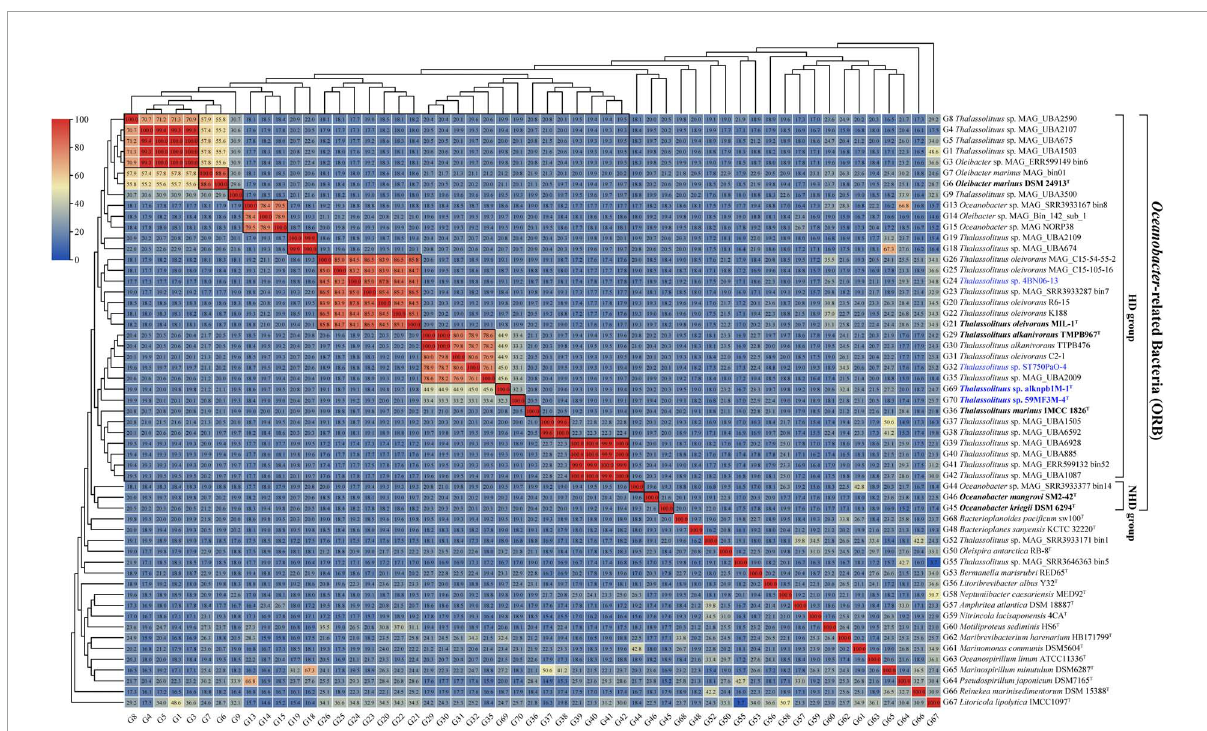
FIGURE4 digital DNA-DNA hybridization (dDDH) value matrices from pairwise genome comparisons. The heatmap shows dDDH values (in each color block) between genomes, along with the phylogenomics tree ( Figure 2A ) cladogram to show relationships. The largest boxed region indicates the revised genus Thalassolituus . Twelve small boxed regions indicate the inferred species clusters within the revised genus Thalassolituus based on dDDH comparisons, as well as monophyly in the genome-based phylogenetic tree ( Figure 2A ). Identically inferred species clusters were also observed from the average nucleotide identity (ANI) value matrices ( Supplementary Figure 3 ). Genomes retrieved from the strains isolated in this study and the type strains of Oceanobacter -related bacteria (ORB) are highlighted in blue and black bold, respectively. Genomes retrieved from the metagenome-assembled genomes are marked by "metagenome-assembled genomes (MAG)" in their names.